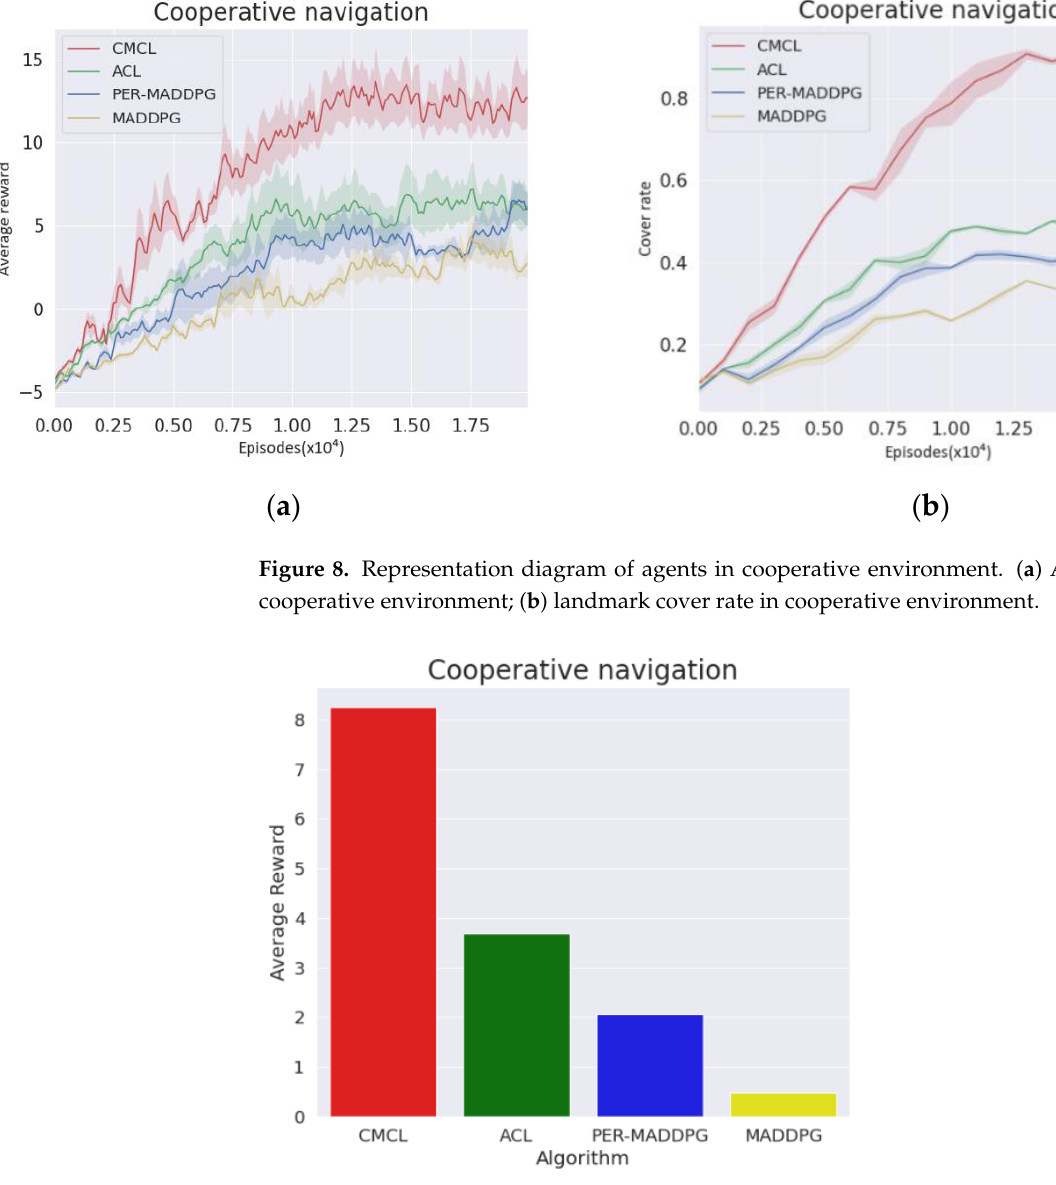
Figure 9. Bar chart of average reward value in cooperative environment.